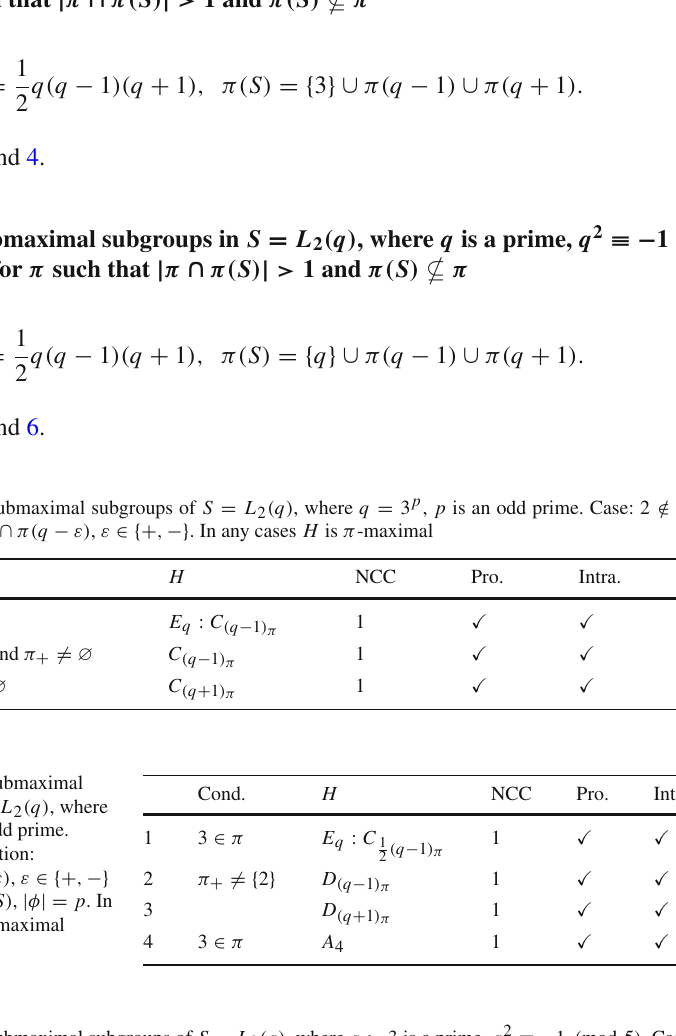
Table 5 The π -submaximal subgroups of S = L 2 ( q ) , where q > 3 is a prime, q 2 ≡ − 1 ( mod 5 ) . Case: 2 / ∈ π . Notation: π ε = π ∩ π( q − ε) , ε ∈ {+ , −} . In any cases H is π -maximal